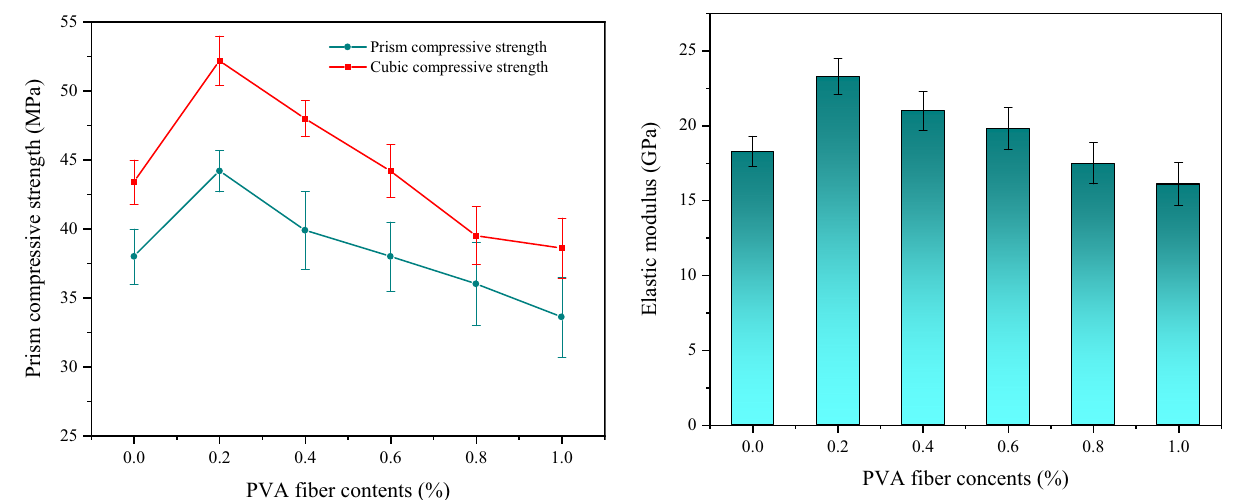
Figure 13: Elastic modulus versus PVA fi ber